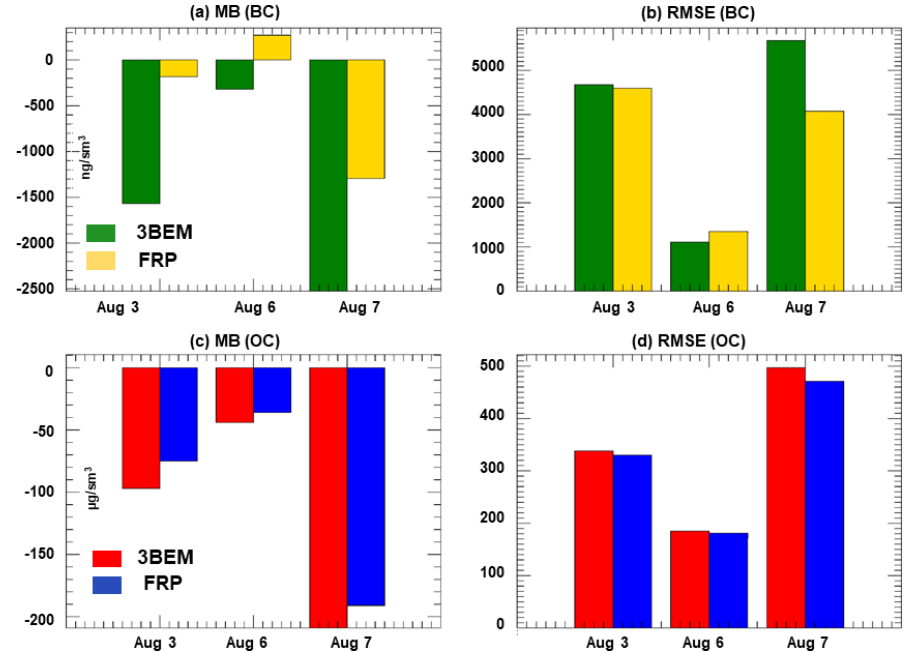
Figure 12. Statistical metrics of comparisons for BC and OC for the 3, 6, and 7 August DC-8 science flights. The average bias (MAB) and the root-mean-squared error (RMSE) for BC (a, b) and OC (c, d) are